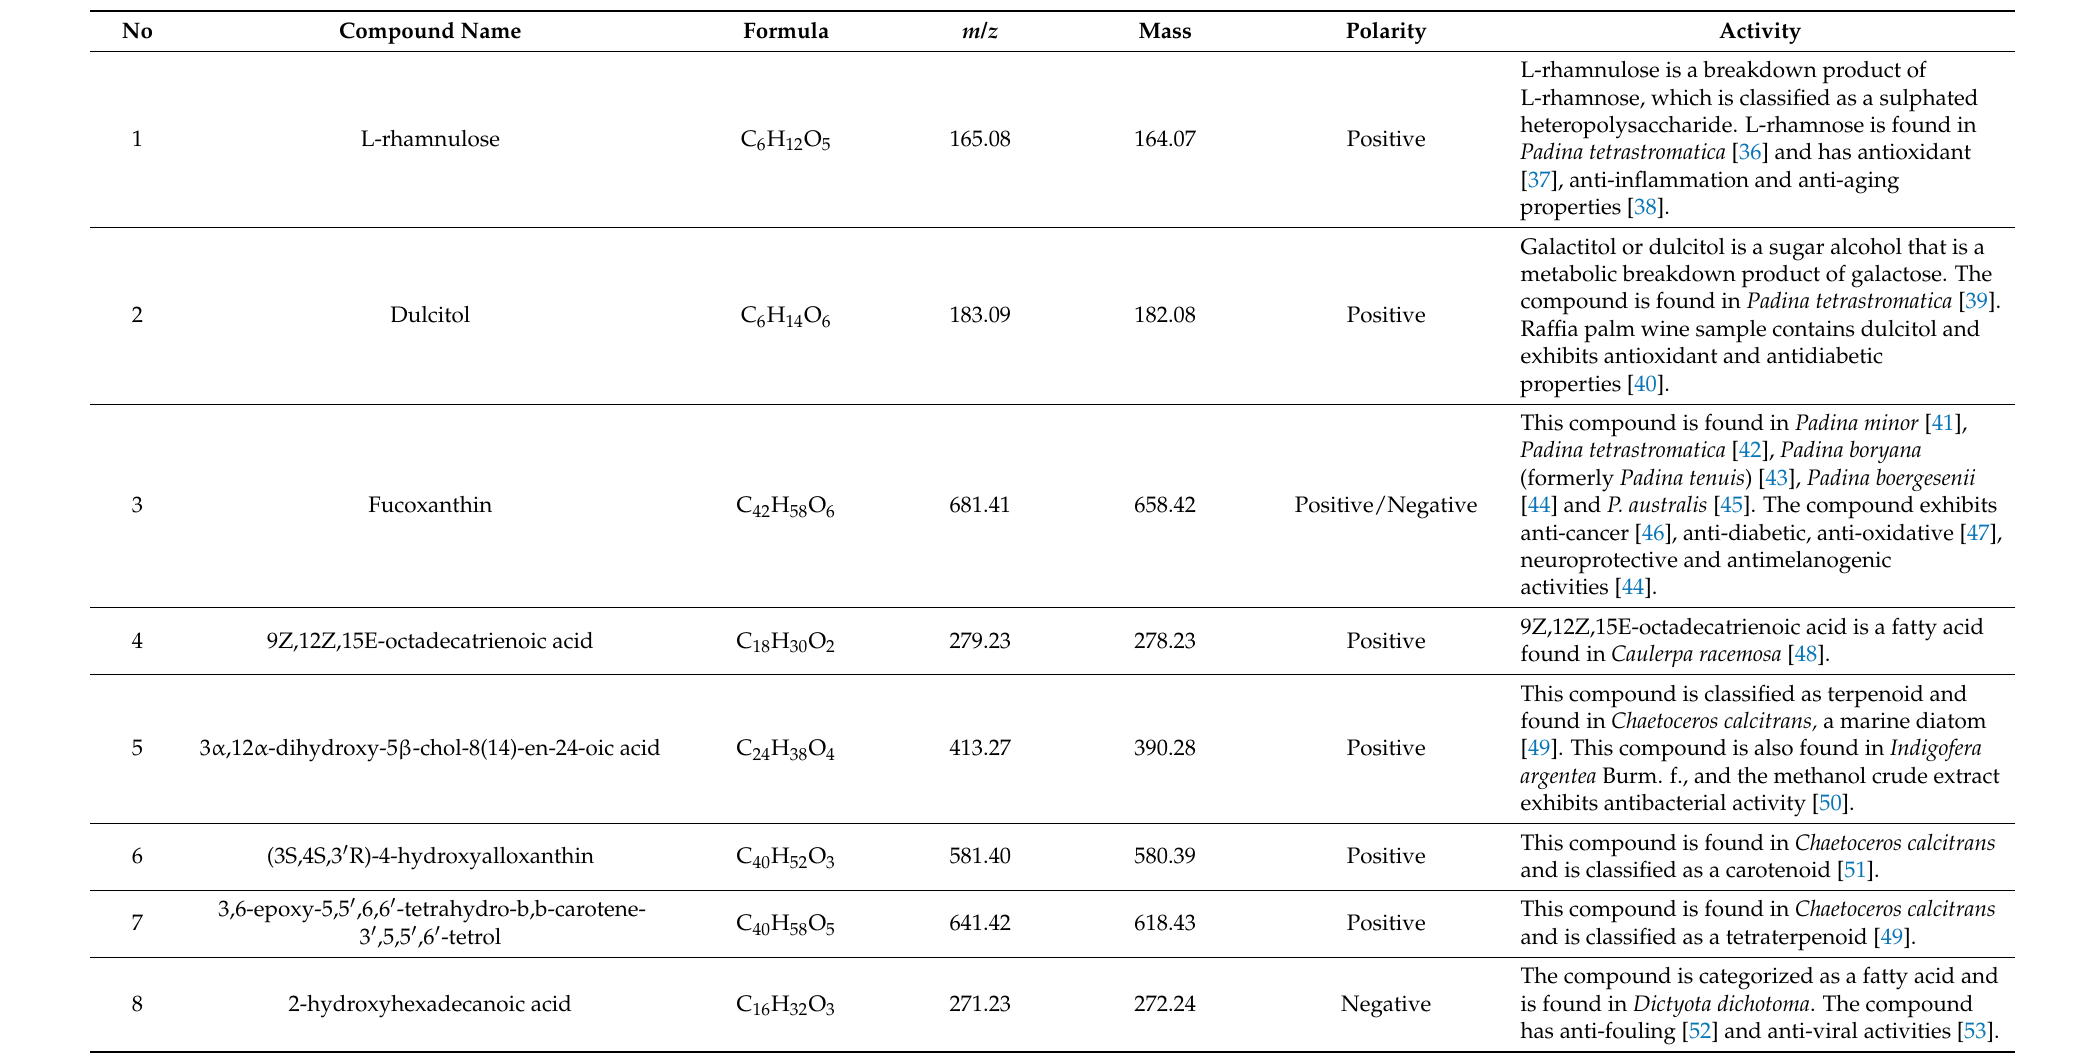
Table 3. Predicted compounds in the P. australis ethanol extract identified through LC-MS